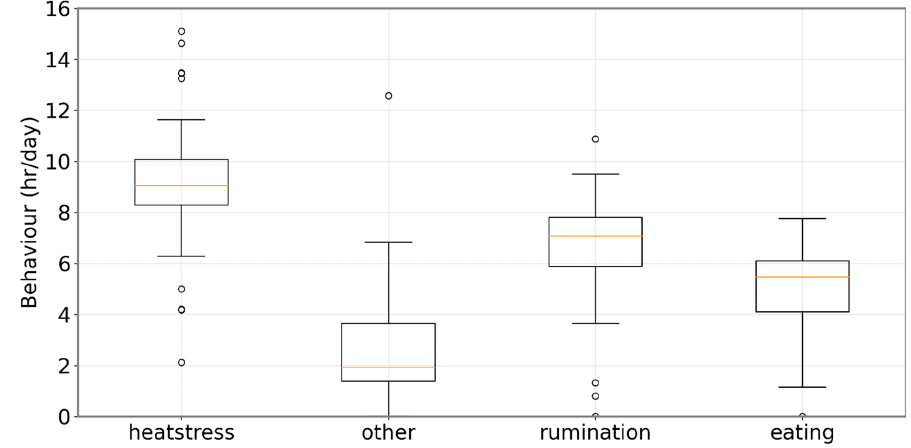
Figure 9. Estimates of Daily Time Budgets over the observation period.